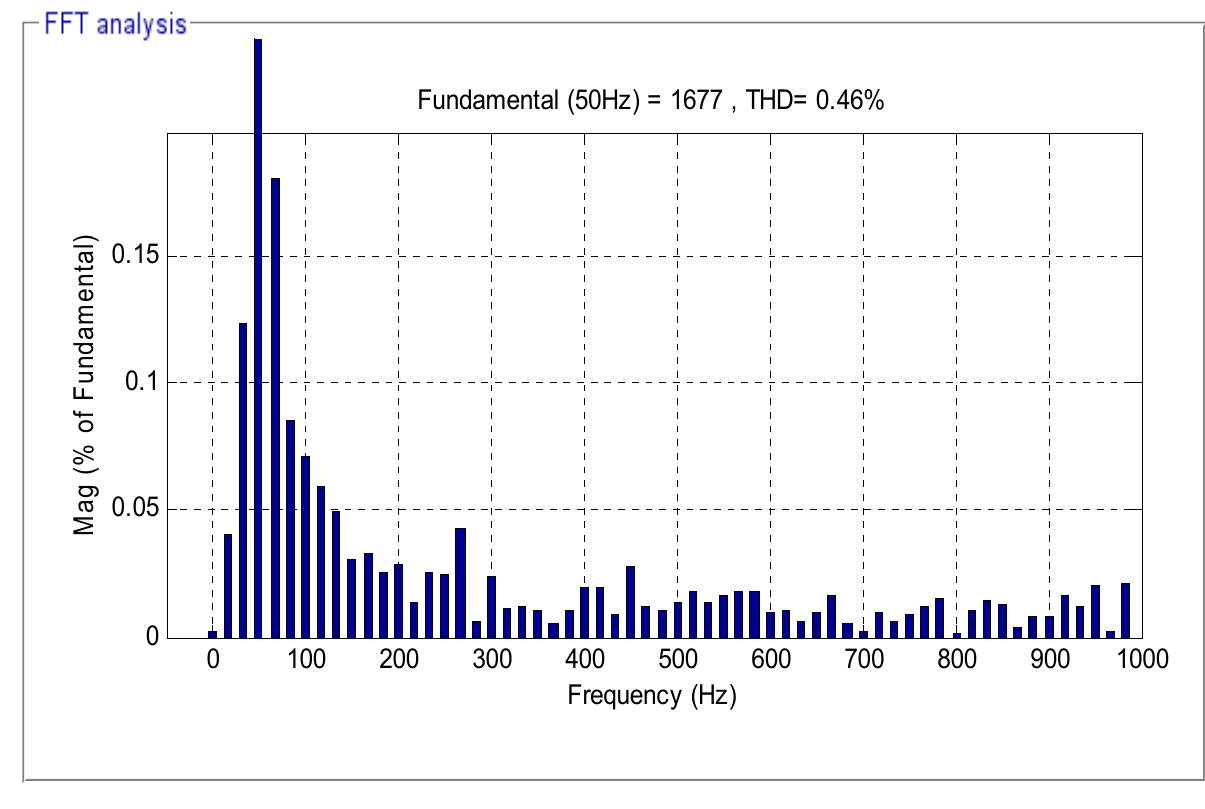
Figure 15. THD of current (DARPC-PI).